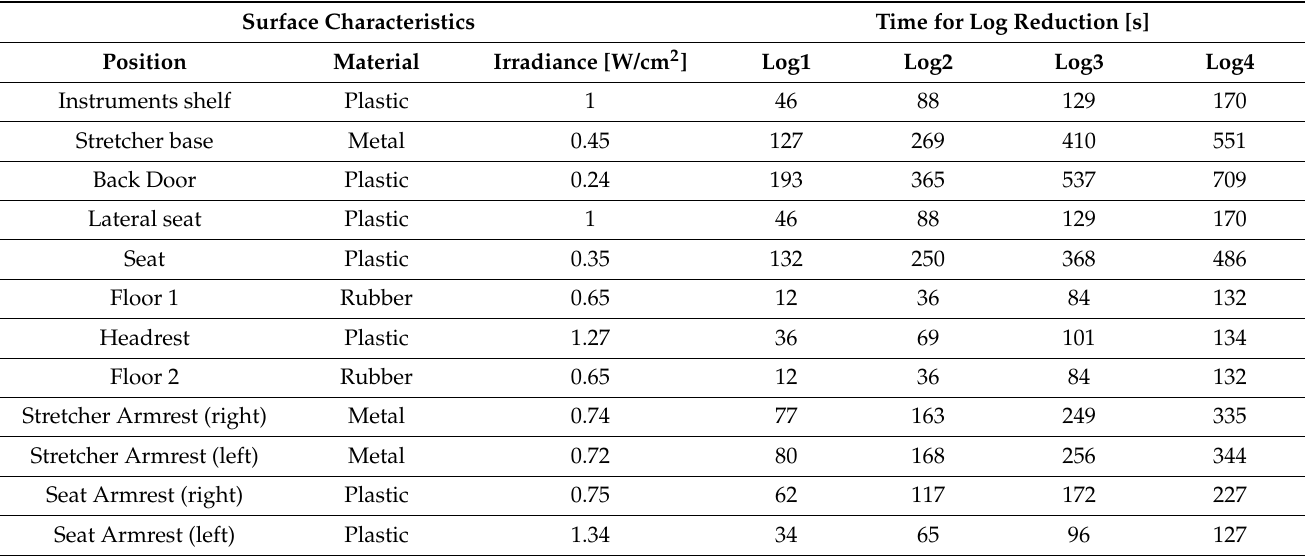
Table 6. Evaluation of time needed to reduce the SARS-CoV-2 virus over different surfaces in the patient compartment of the